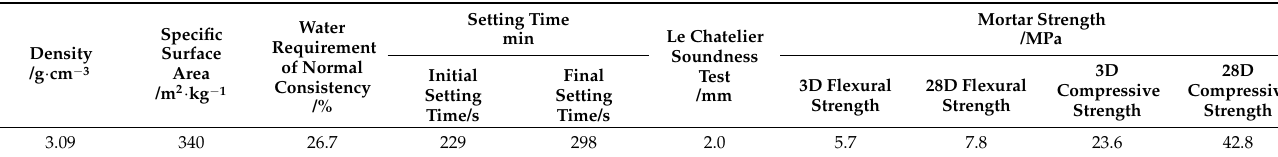
Table 1. Guizhou Linshan PO42.5 cement physical and chemical indexes.